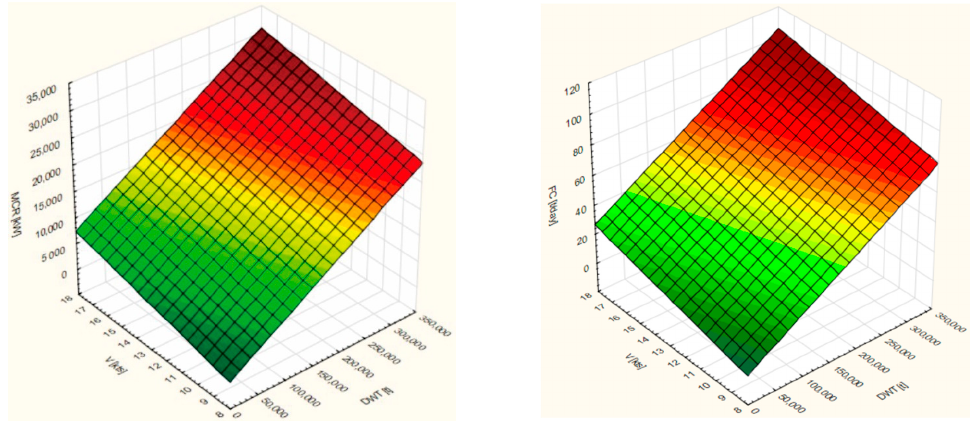
Figure 10. Estimated MCR and FC values in the full range of DWT and V calculated for tankers by the use of Equations (9) and (10).